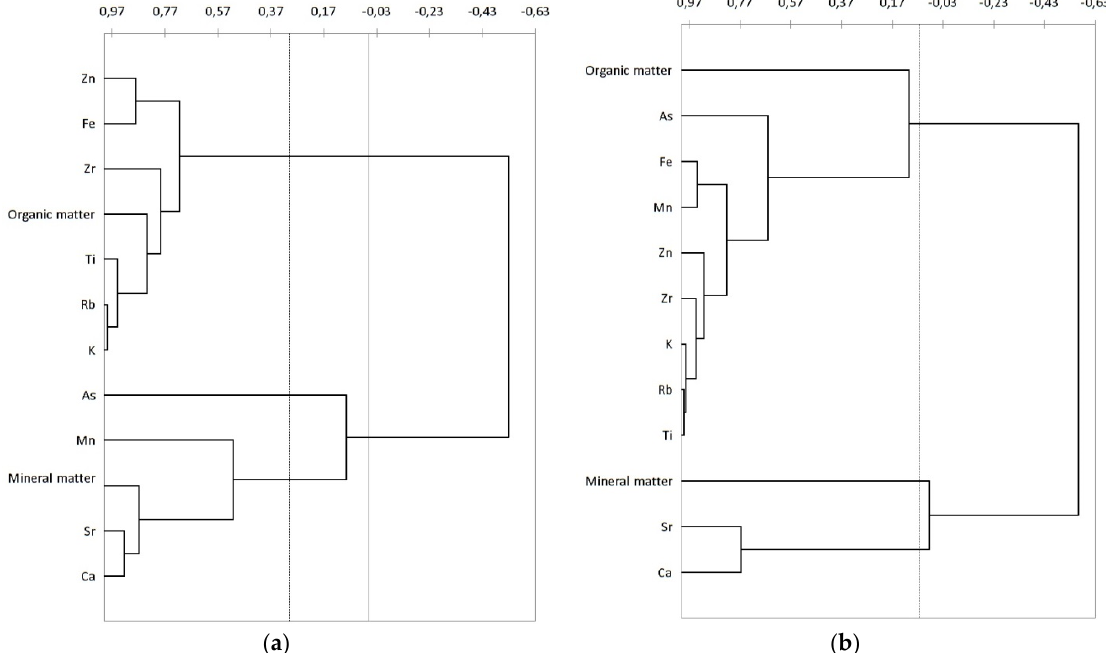
Figure 10. Cluster analysis (Spearmann correlation matrix, p < 0.05) of data from Lakes Balsys ( a ) and Didžiulis ( b ).